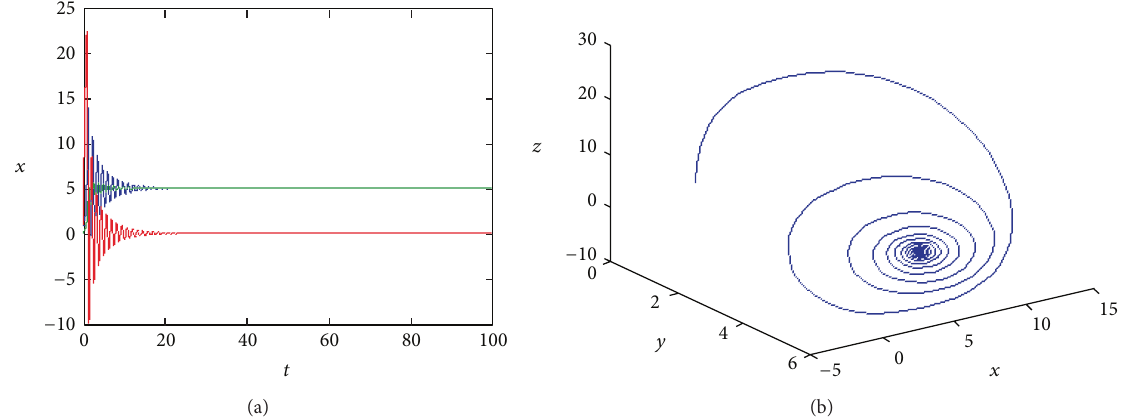
Figure 5: Time history and phase diagram of system (31) with 𝑎 = −1.5 , 𝑏 = 25 , 𝑘 = −0.1 .